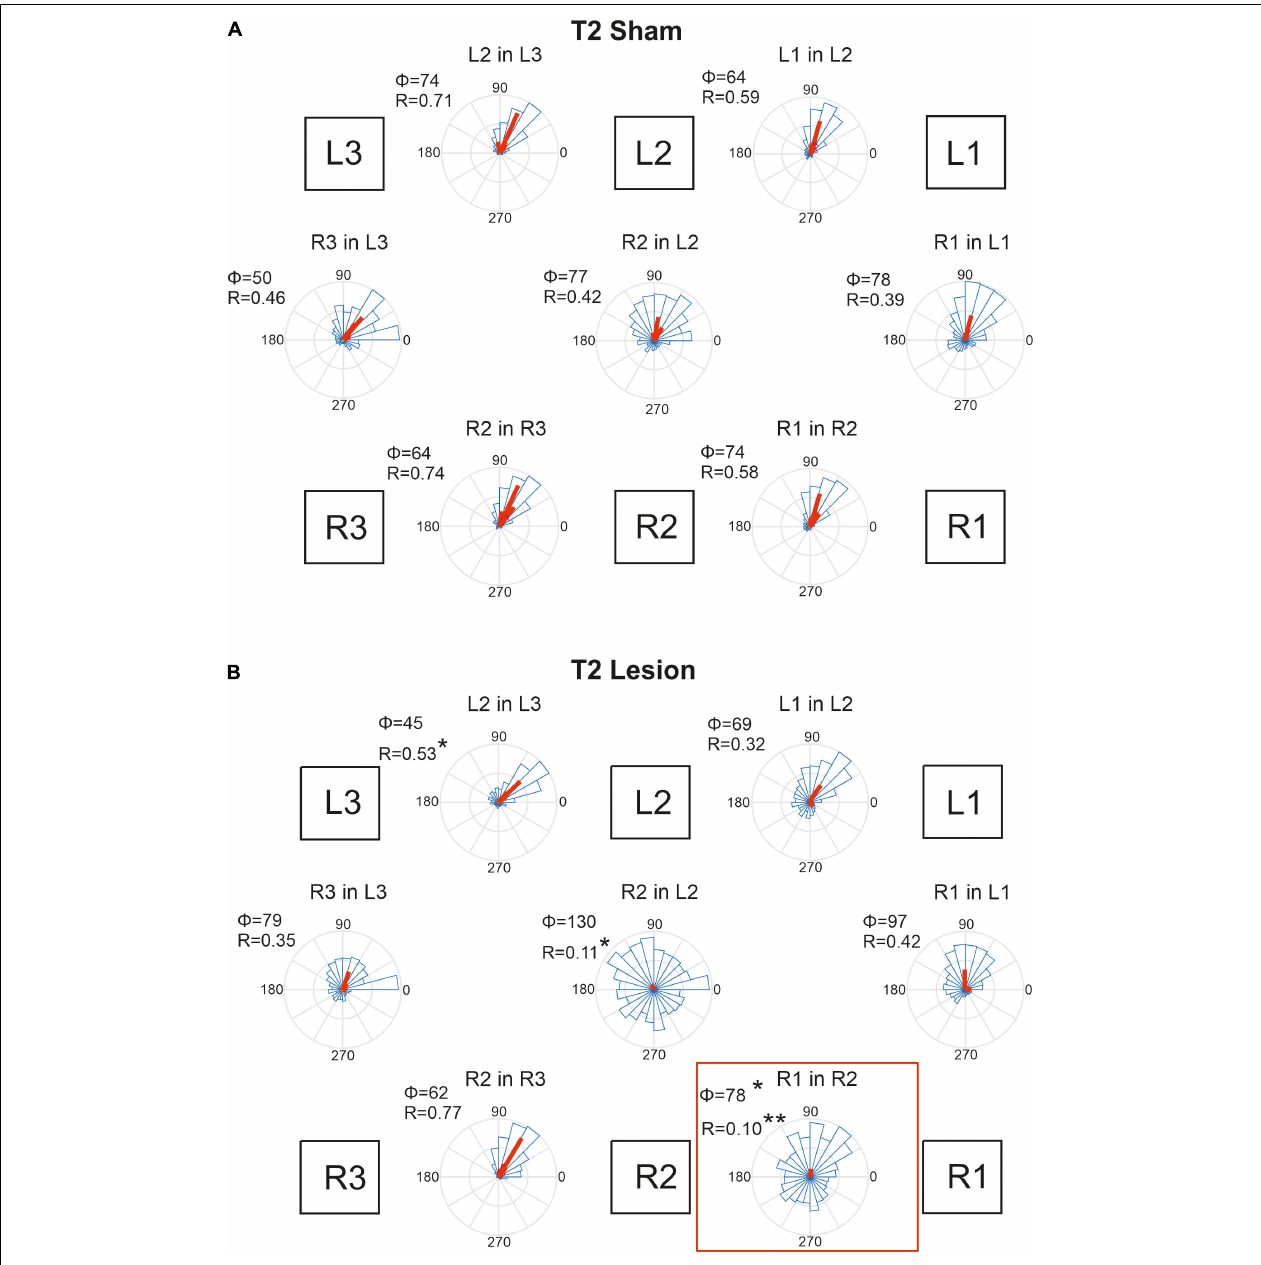
FIGURE 9 | Temporal coordination of step cycles after an operation in the mesothorax. (A) Sham-operated animals. (B) Animals with a lesion of the right pro-to-mesothorax connective (T2 lesion). Square boxes labelled L1–L3 and R1–R3 show the arrangement of the six legs. For each leg pair labelled “Leg1 in Leg 2”, rose plots show pooled distribution (blue) and per-animal mean phase shifts (cid:56) (red) of the onset of swing by Leg 1 (receiver leg) in relation to the step cycle of (sender) Leg 2. Accordingly, (cid:56) = 0 indicates that L1 lifted off at the same time as L2 touched down. Circular histograms comprise all steps per cohort in 15 deg. bins. Statistics were calculated on per-animal mean phase vectors, with (cid:56) and R giving the corresponding angle and length of that vector, respectively. Significance levels, * p < 0.05; ** p <